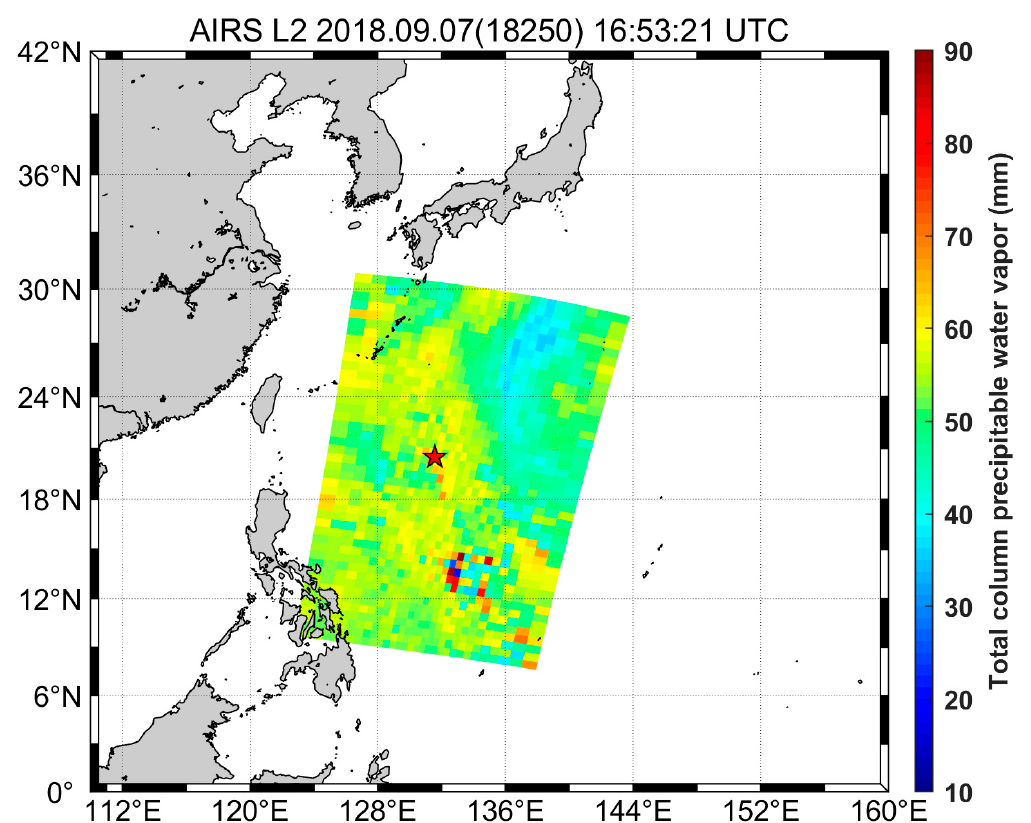
Figure 8. AIRS-PWV observation at the specific time and the location of the vessel ISABU (red star) at that time. The AIRS-PWV was averaged by extracting the observed values within the latitude ± 0.5° and longitude ± 0.5° from the ship’s position.